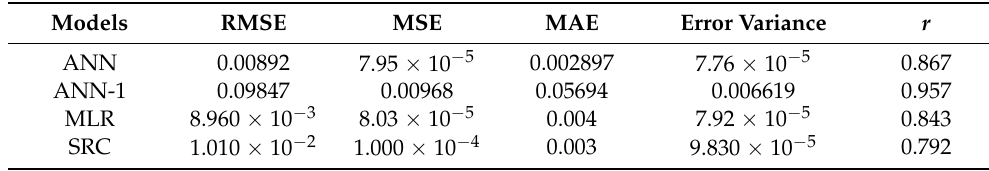
Table 5. Performance comparisons in testing data error statistics of the ANN model and ANN-1 model of Tikarapara Station of the